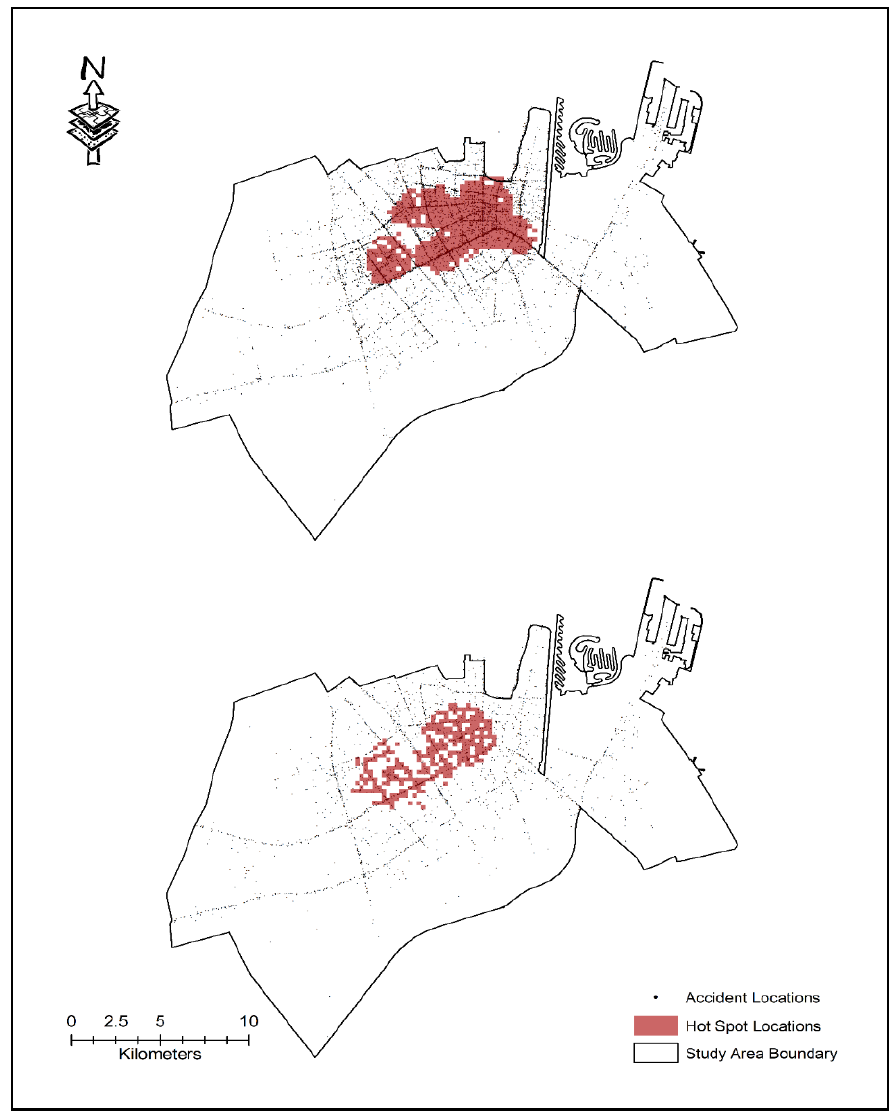
Figure 4. Distribution of hotspots by crash severity: property damage only (PDO) ( top ); fatal and injury (FI) ( bottom ).